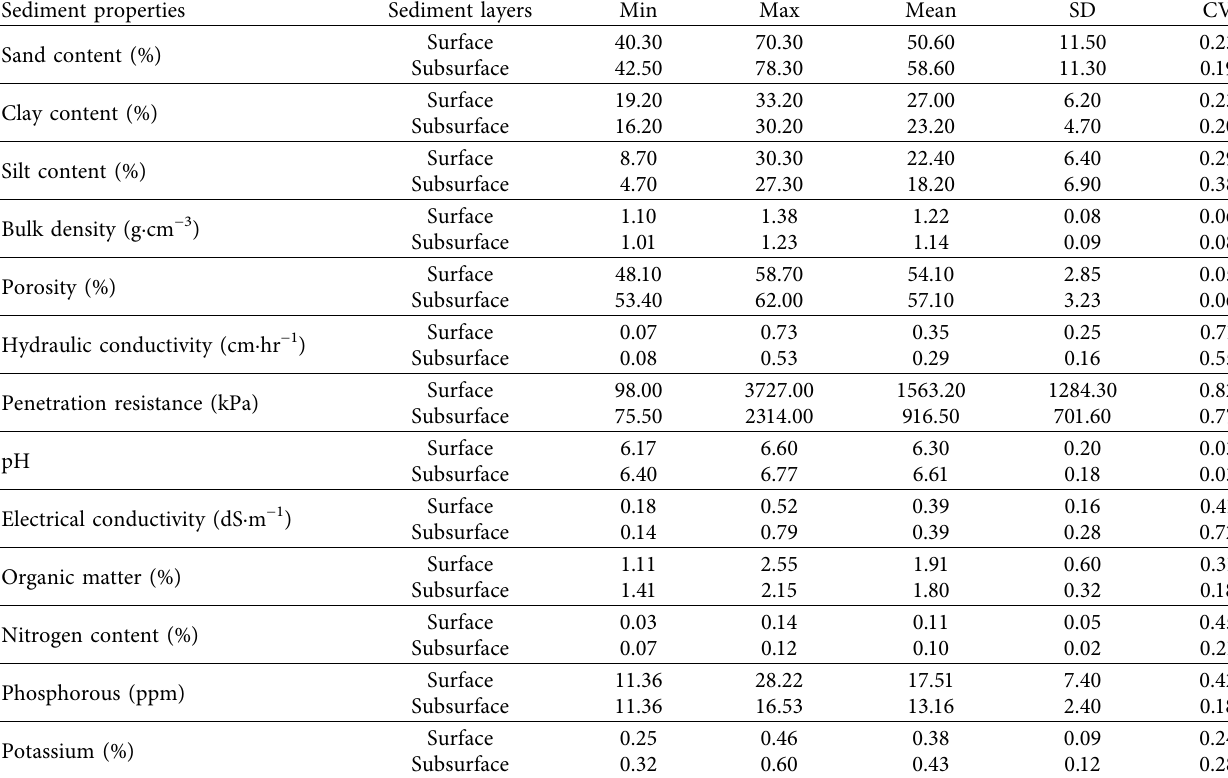
Table 1: Physicochemical properties of the deposited